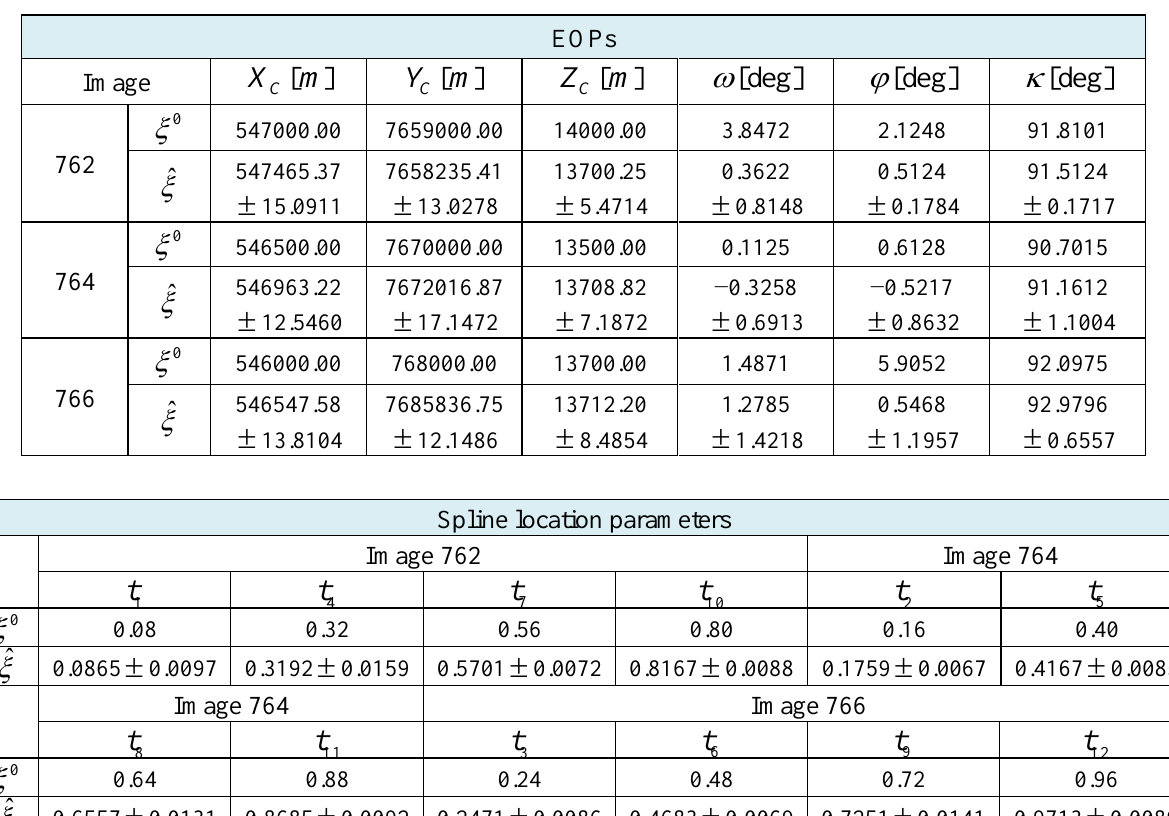
Table 11. EOP and spline location parameter